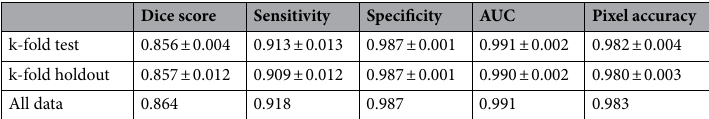
Table 1. Accuracy of AngioNet using K-fold cross validation.